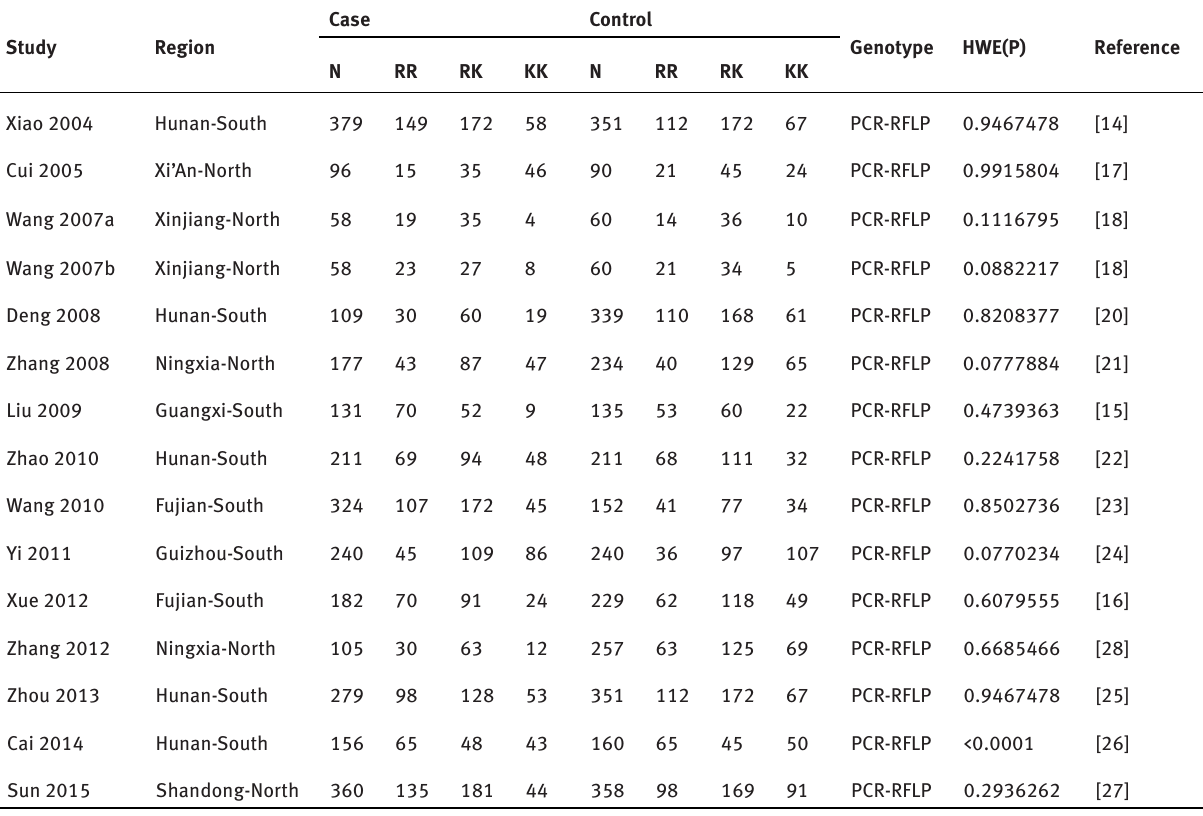
Table 1: Characteristics of included studies for the meta-analysis of R219K and ischemic stroke in Chinese population